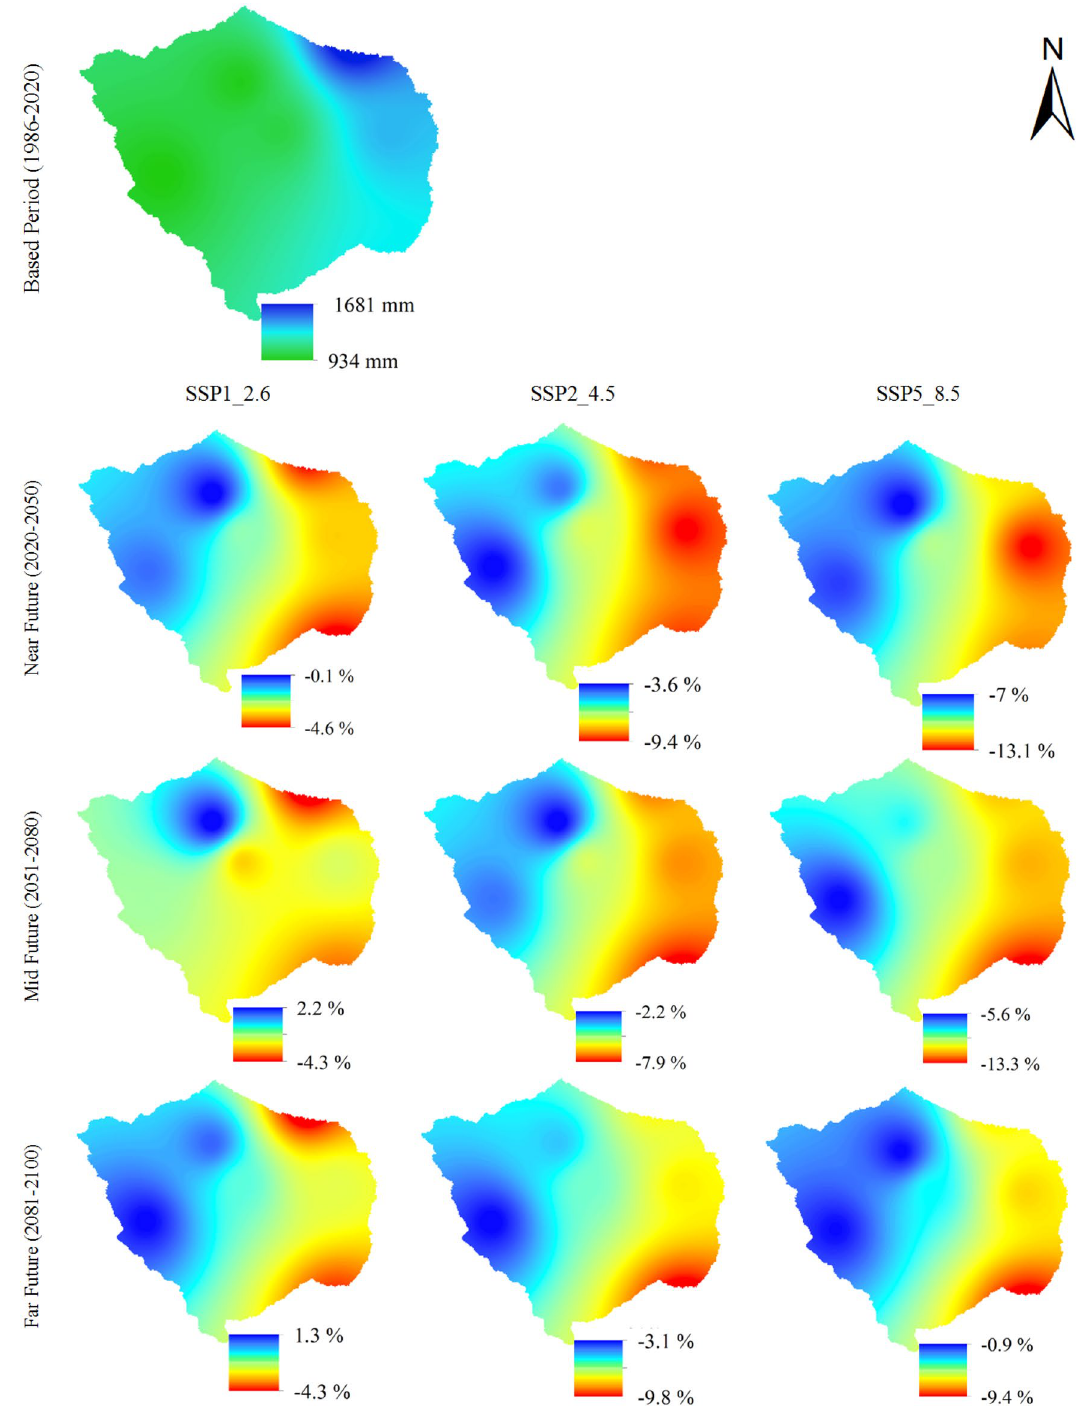
Figure 5. Mean annual precipitation over the basin for the base period (1986–2020), and the spatial distribution of changes in precipitation for mean multi-GCMs under SSP1-2.6, SSP2-4.5, and SSP5-8.5 in